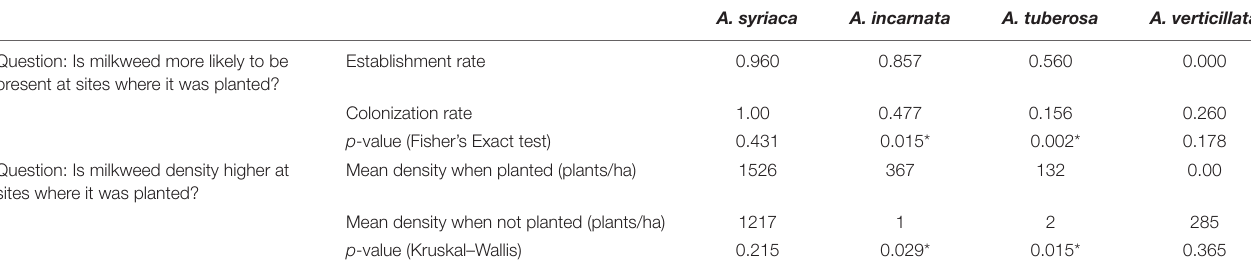
FIGURE 2 | Milkweed occurrence by species. Total number of sites = 58; seed mix data were not available for 3 of 61 sites. TABLE 3 | Comparison of the presence and densities of milkweed species at sites where milkweeds were planted (establishment) and at sites where they were not